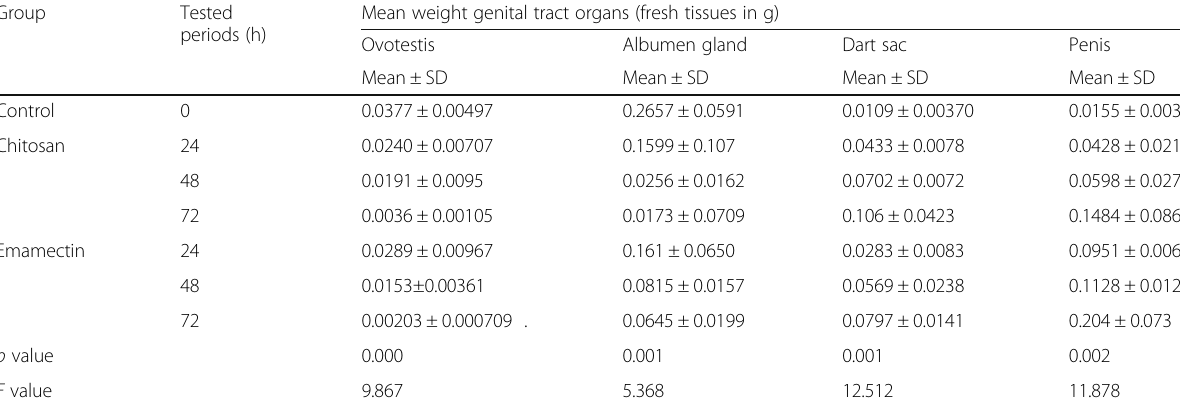
Table 2 Mean weights LC 50 of chitosan or emamectin benzoate of the reproductive system organs of Eobania vermiculata using the residual film technique